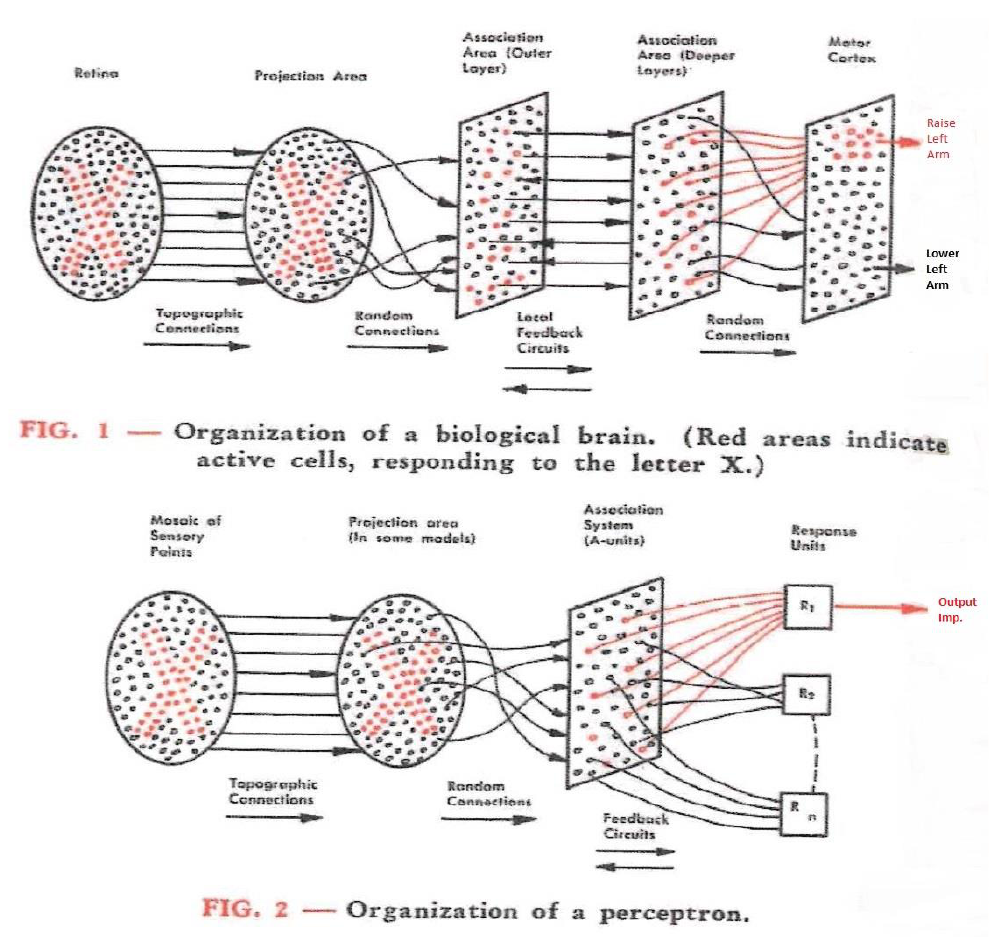
Figure 5. Organization of a biological brain and a perceptron [16] (p. 2), the picture was modified for better readability).